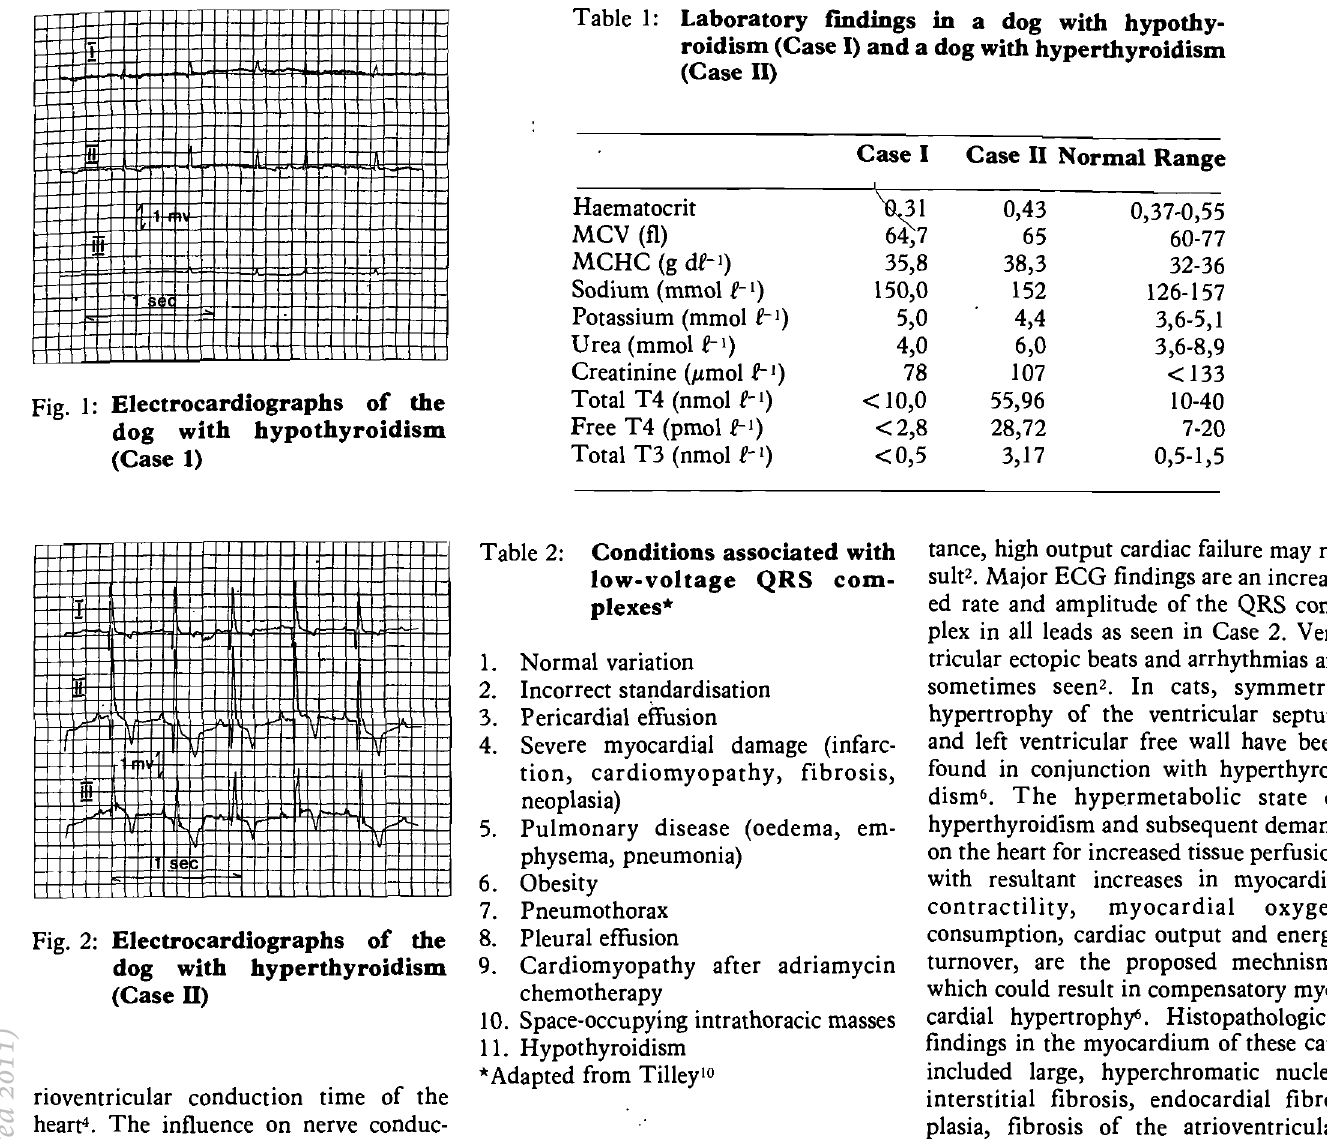
Fig. 2: Electrocardiographs of the dog with hyperthyroidism (Case II)